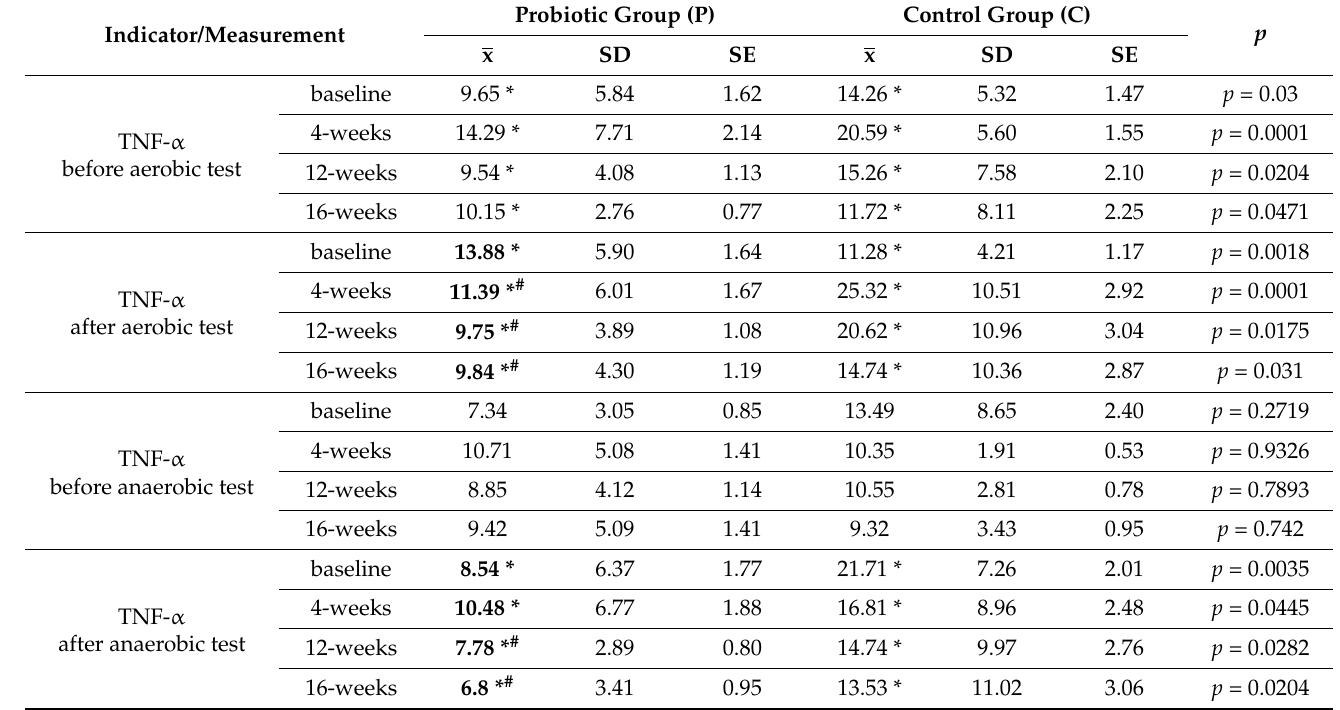
Table 8. The mean TNF- α values during pre- and post-aerobic and during pre- and post- anaerobic tests at follow-up measurements during supplementation